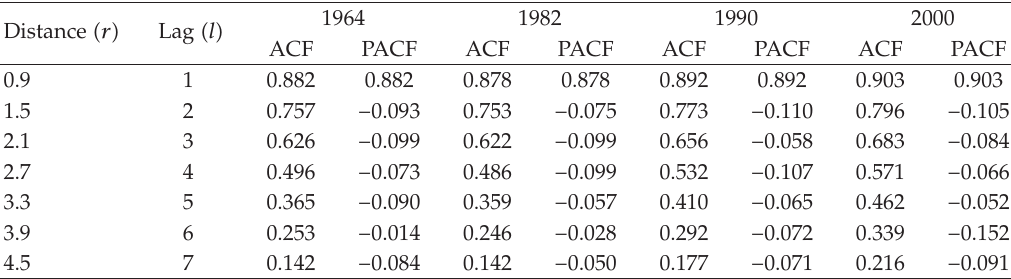
Table 3: Autocorrelation function (cid:6) ACF (cid:7) and partial autocorrelation function (cid:6) PACF (cid:7) values of Hangzhou’s population density: 1964–2000. As the sample path is not too long, only the first five values are really significant (cid:6) 26 1 / 2 ≈ 5 (cid:7) . In time or spatial series analysis, we can judge the nature of series by standard error or by Box-Ljung statistic including Q -statistic and corresponding significance. Generally, it is easier and more visual to use the two standard-error bands shown in the